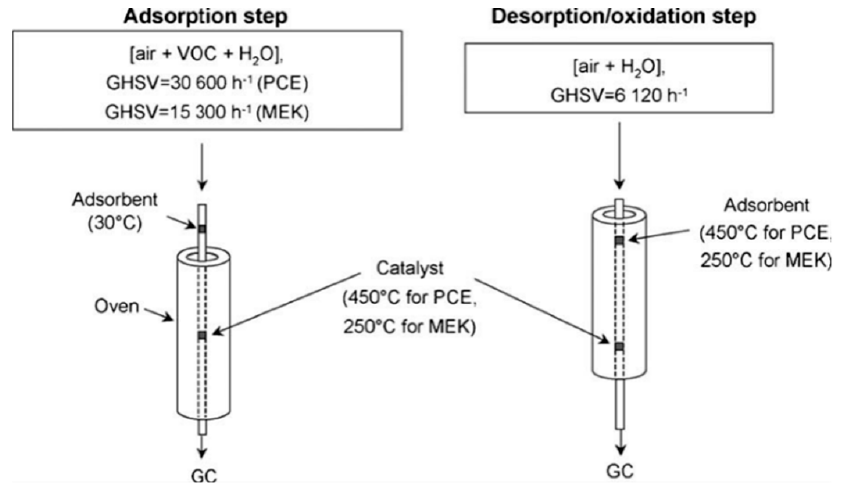
Figure 13. Scheme of adsorption/oxidation apparatus. Reprinted with permission from [1], 2009, Elsevier Ltd.